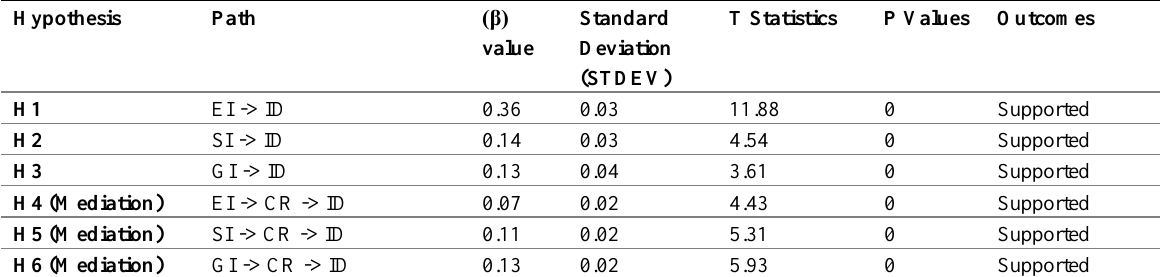
Table 6: Hypotheses